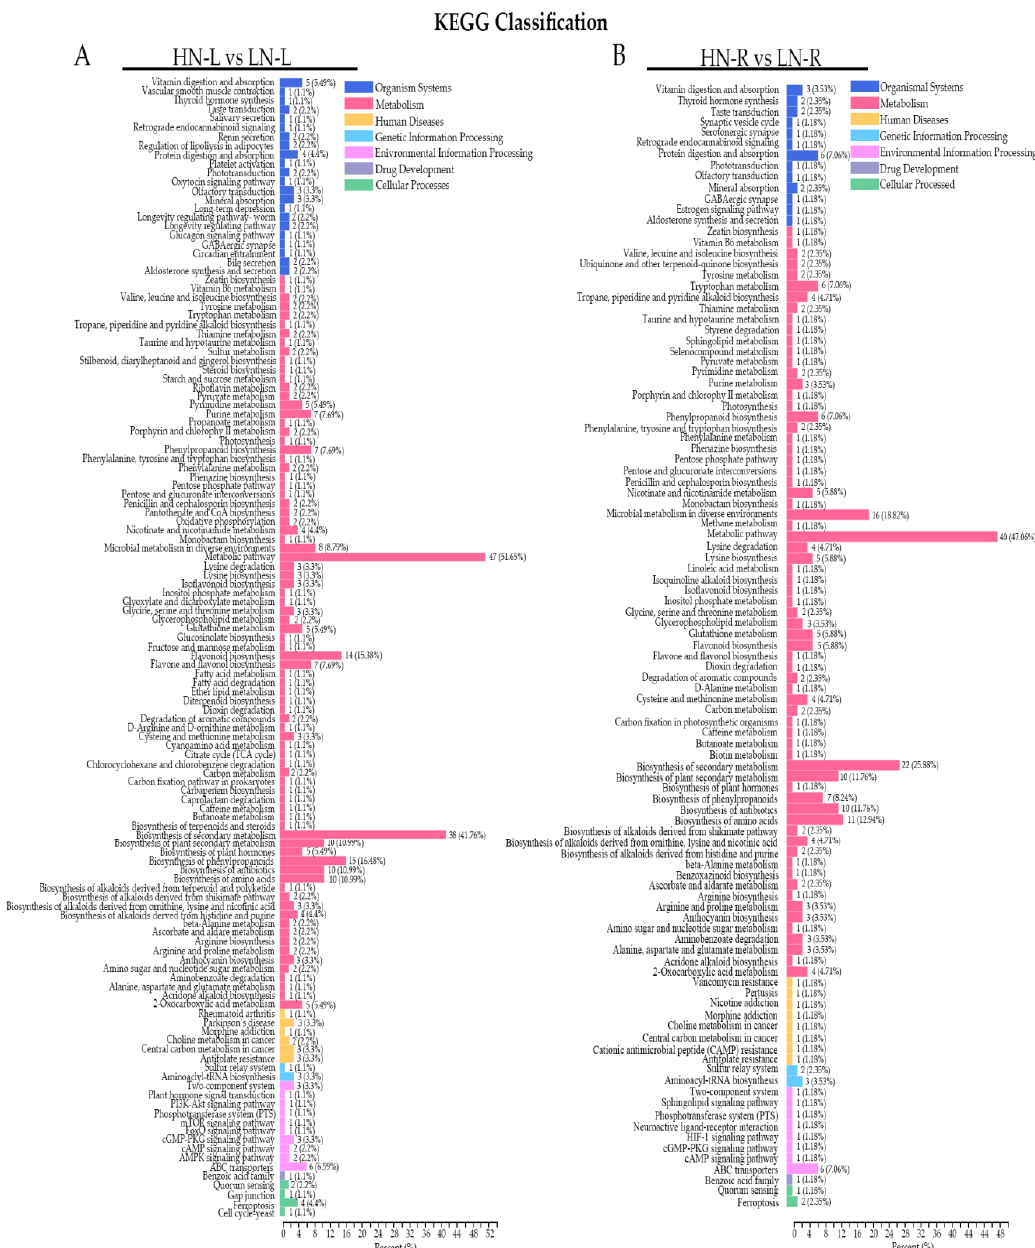
Figure 4. KEGG analysis of the detected metabolites. Functional annotations of the detected metabolites based on metabolite KEGG categorization of the HN-L vs. LN-L ( A ) and HN-R vs. LN-R ( B ).